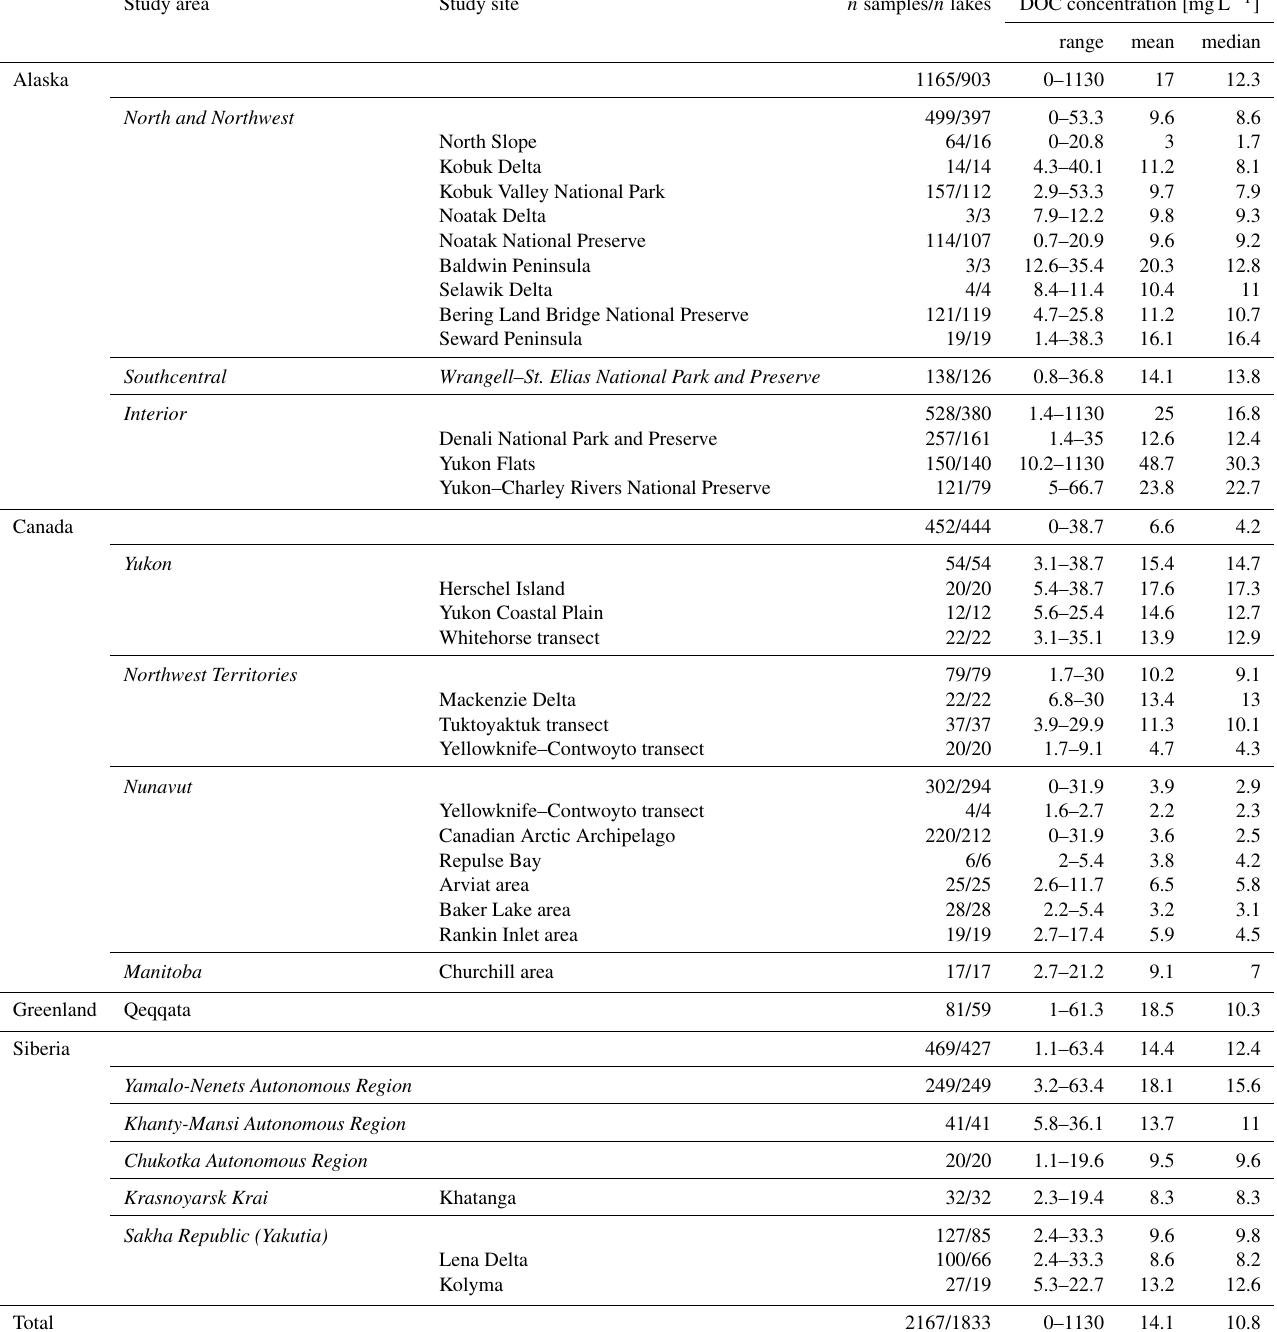
Table A3. DOC concentrations at study